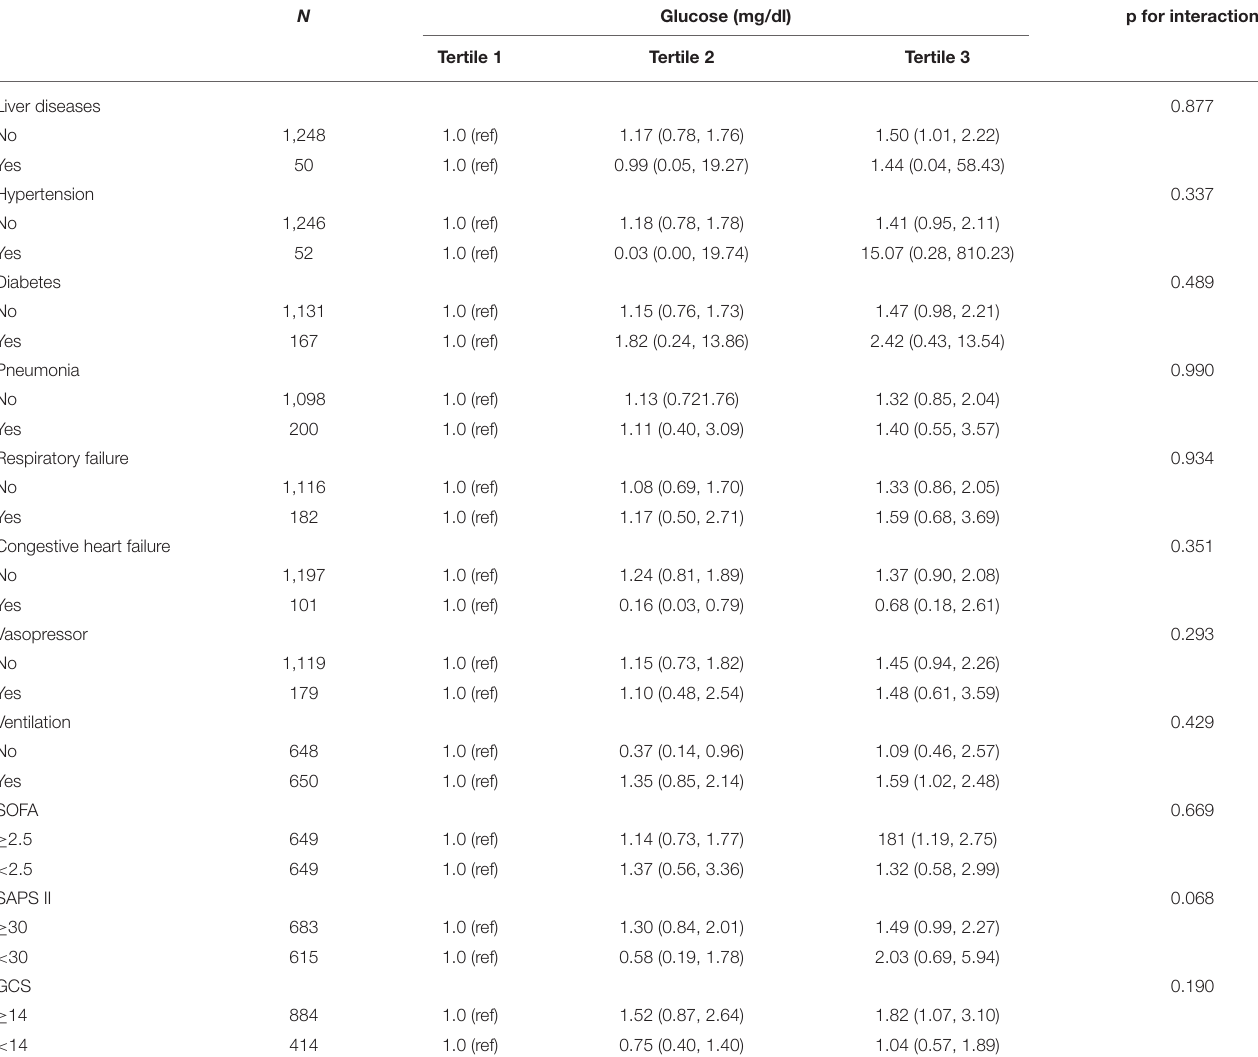
TABLE 3 | Subgroup analysis of the correlation between admission blood glucose and 30-day all-cause mortality in critically ill patients with subarachnoid